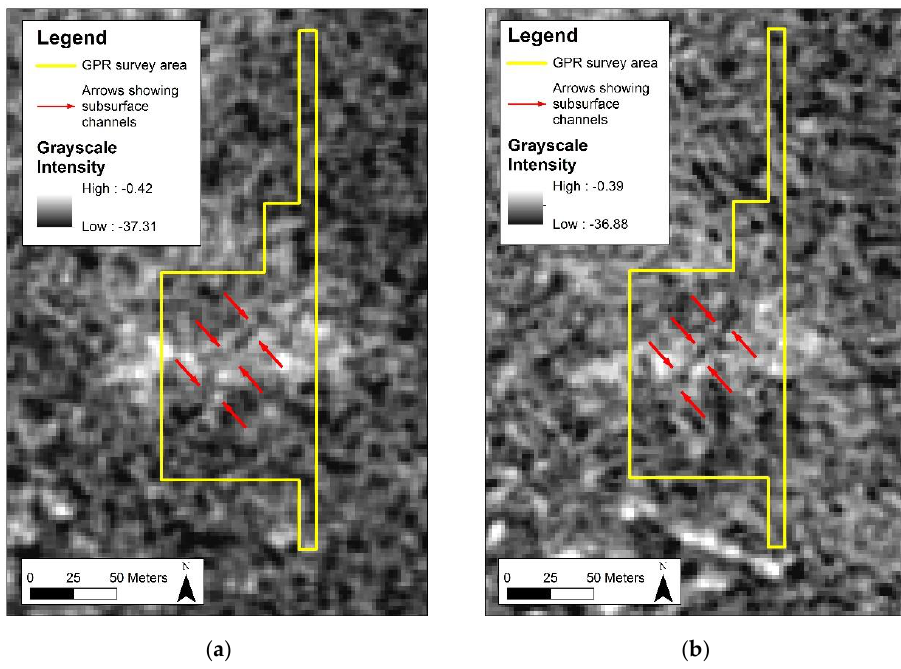
Figure 7. RADARSAT-2 processed grayscale intensity images (db) (low pass 3 × 3 speckle filter applied) with black representing low intensity values and white representing high intensity values. ( a ) 30 October 2017 VV image. ( b ) 2 July 2017 HH image.